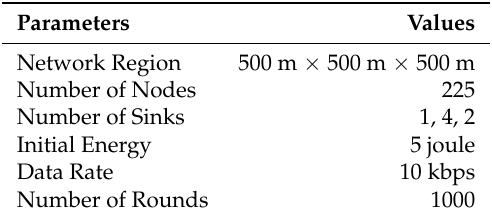
Table 2. Simulation